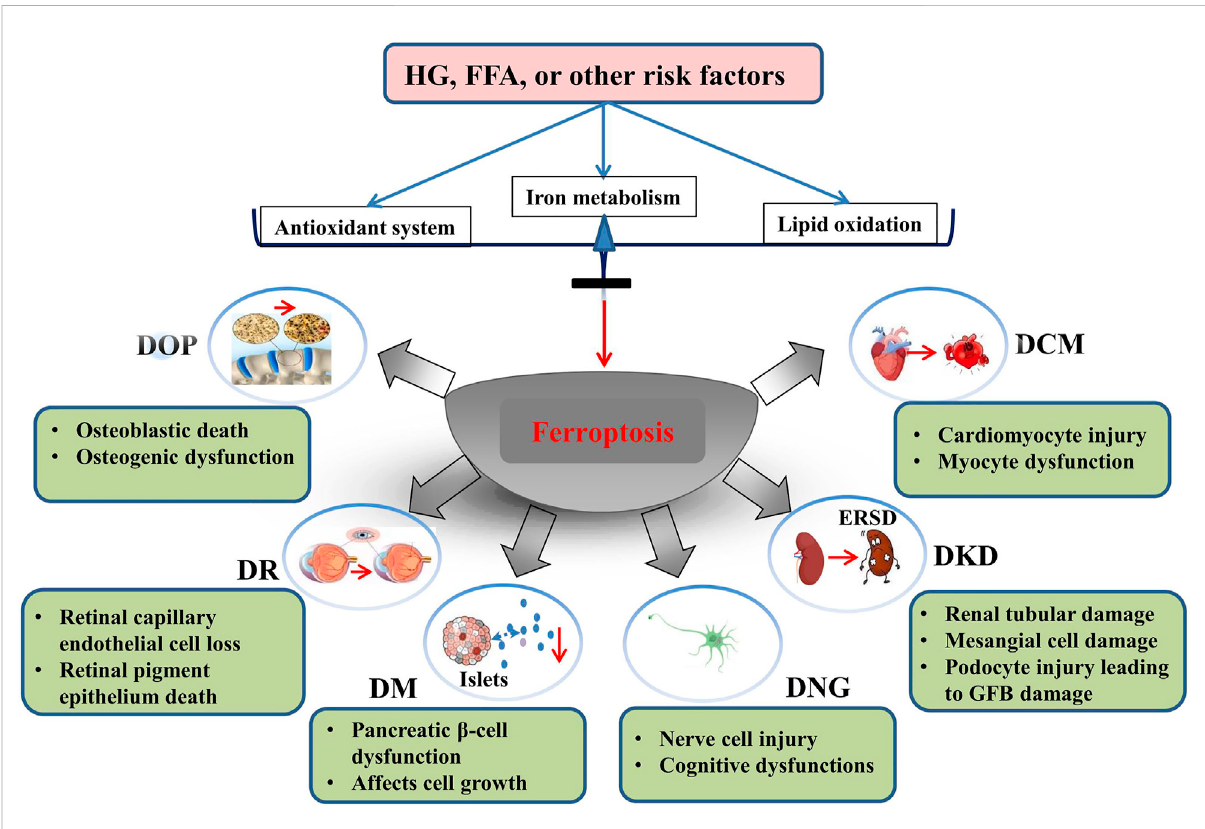
FIGURE 1 Role of ferroptosis in the development of diabetes mellitus and its complications. HG, high glucose; FFA, free fatty acids; DOP, diabetic osteoporosis; DR, diabetic retinopathy; DM, diabetes mellitus; DNG diabetic neuropathy; DKD, diabetic kidney disease; DCM, diabetic cardiomyopathy. Reproduced with permission from (Yang and Yang, 2022). Copyright 2022, Frontiers in